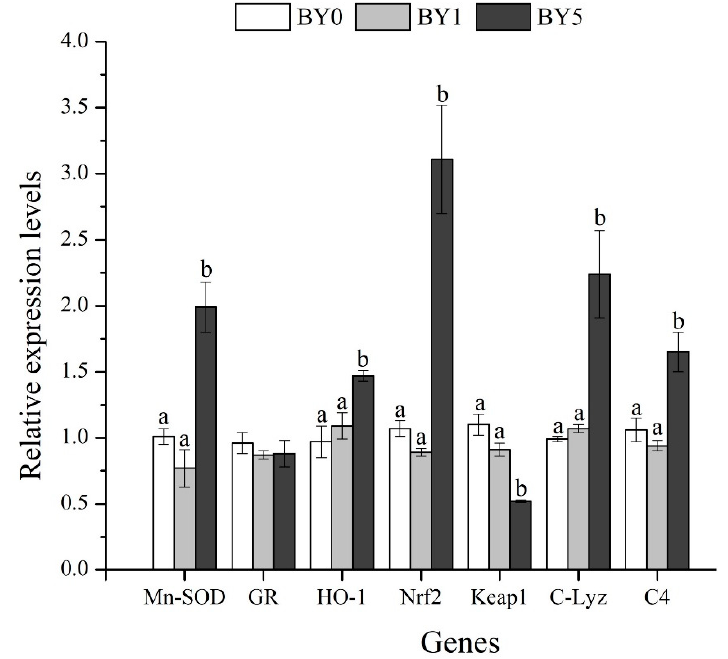
Figure 7. Relative expression levels of antioxidant-related and immune-related genes in the liver of T. ovatus fed experimental diets. Values are presented as mean ± SE ( n = 18). The small letters indicate significant differences at p < 0.05. Mn-SOD, manganese superoxide dismutase; GR, glutathione reductase; HO-1, haeme oxygenase-1; Nrf2, NF-E2-related nuclear factor 2; Keap1, Kelch-like-ECH- associated protein 1; C-Lyz, c-type lysozyme; C4, complement 4.